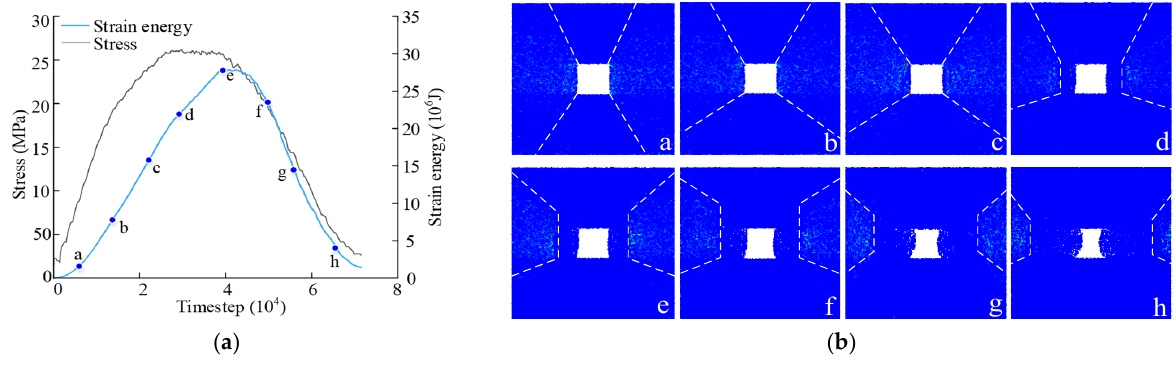
Figure 14. Cloud diagram of strain energy evolution of roadway surrounding rock. ( a ) Strain energy evolution curve of roadway surrounding rock. ( b ) Strain energy evolution range of roadway sur- rounding rock.